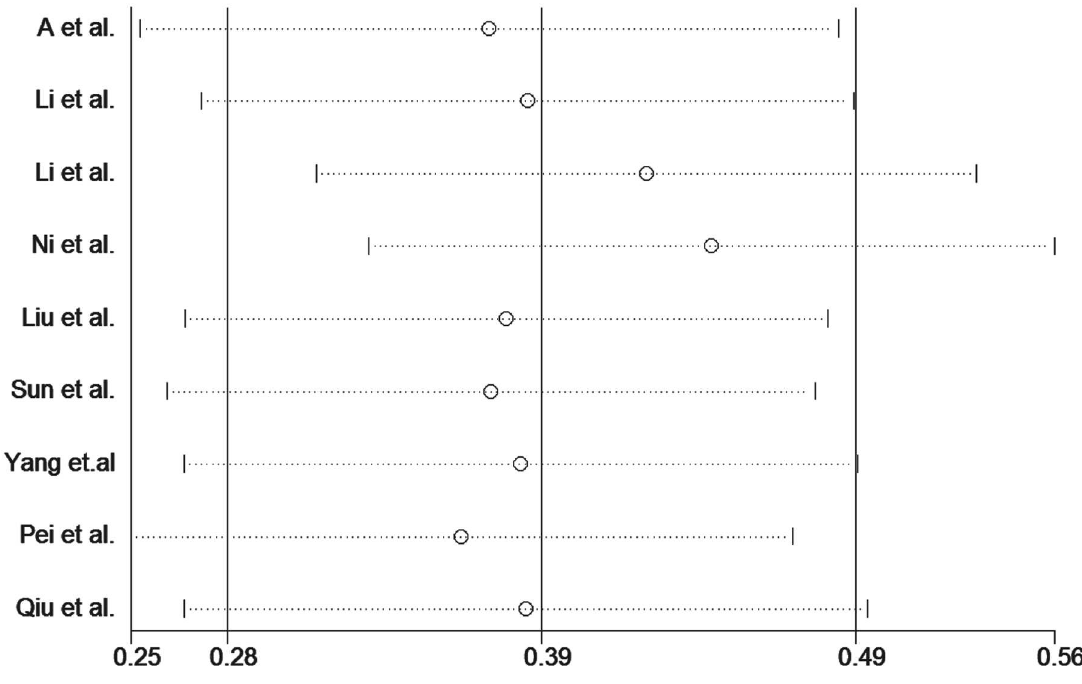
Fig 7. Sensitivity analysis diagram for each study used to assessthe relative risk estimates for the MTHFR C677T polymorphism and male infertility in all of the included studies. (allelicmodel: T vs. C).